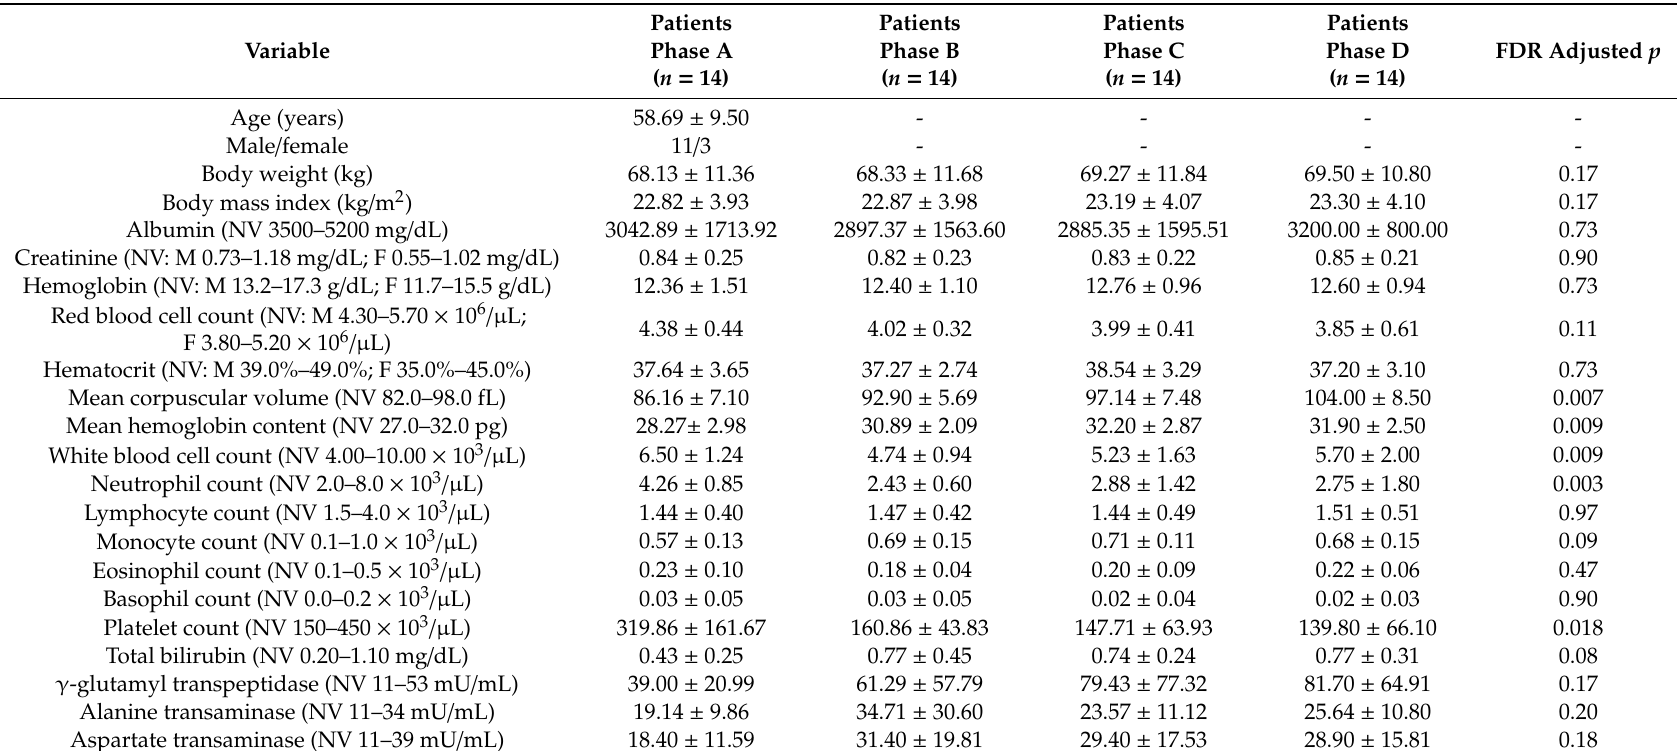
Table 2. Demographic, anthropometric, biohumoral variables of the study patient